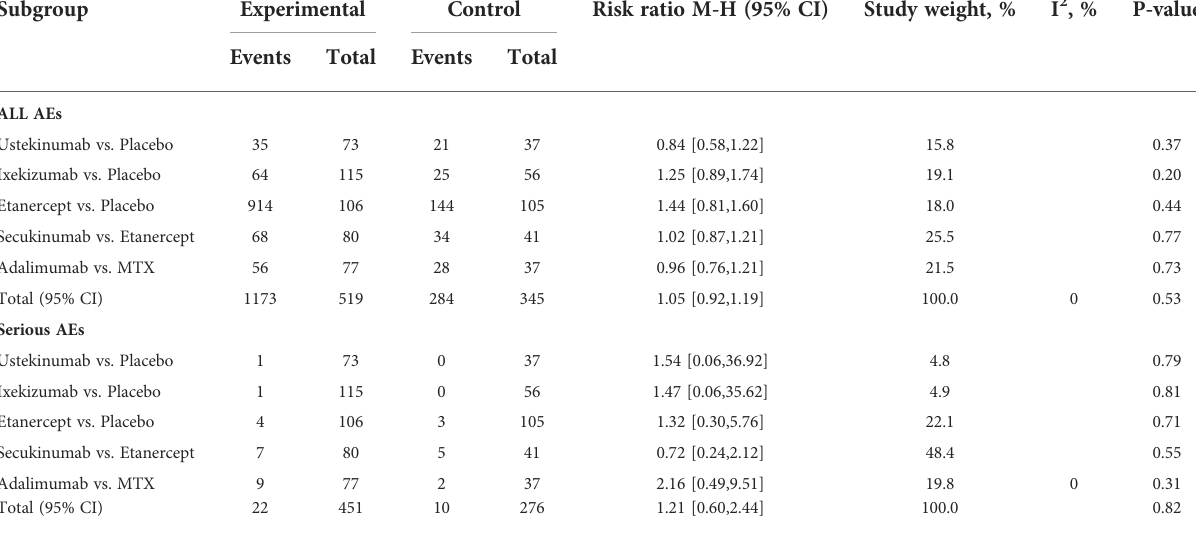
TABLE 3 Adverse events and serious adverse events reported for biological agents used in pediatric patients with